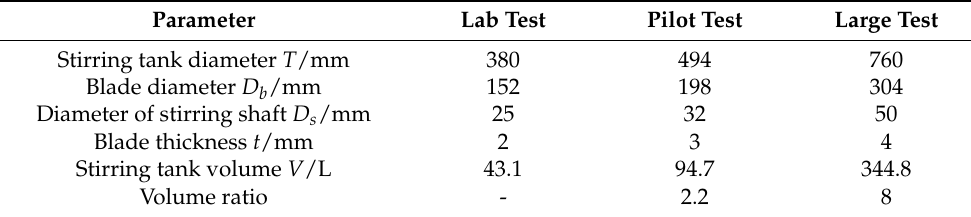
Table 13. Structural parameters of three scales of